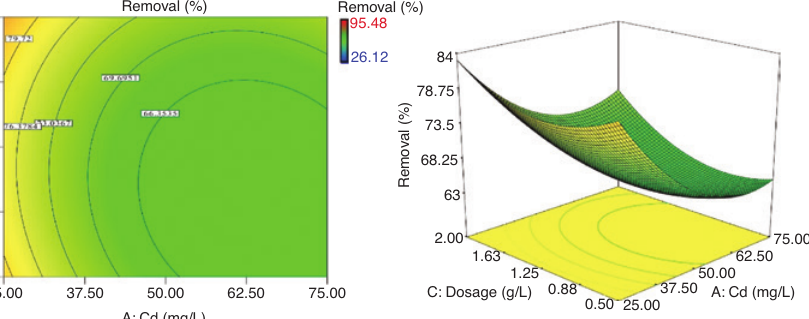
Figure 5: The contour and three-dimensional diagrams of Cd removal efficiency (%) as a function of initial Cd concentration and adsorbent